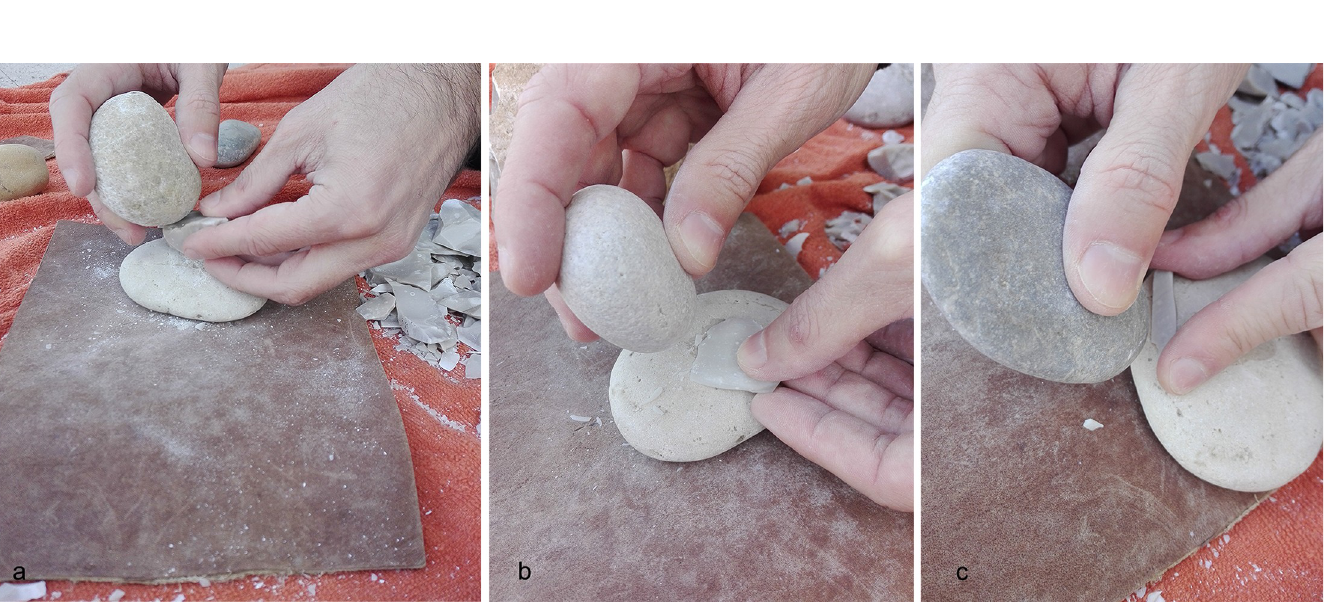
Fig 6. Experimental bipolar percussion and retouch on anvil. (a) Bipolar percussion for flake production; (b) hinged laminar flake retouch on anvil adopting a rectilinear trajectory; (c) bladelet retouch on anvil adopting an oblique trajectory.